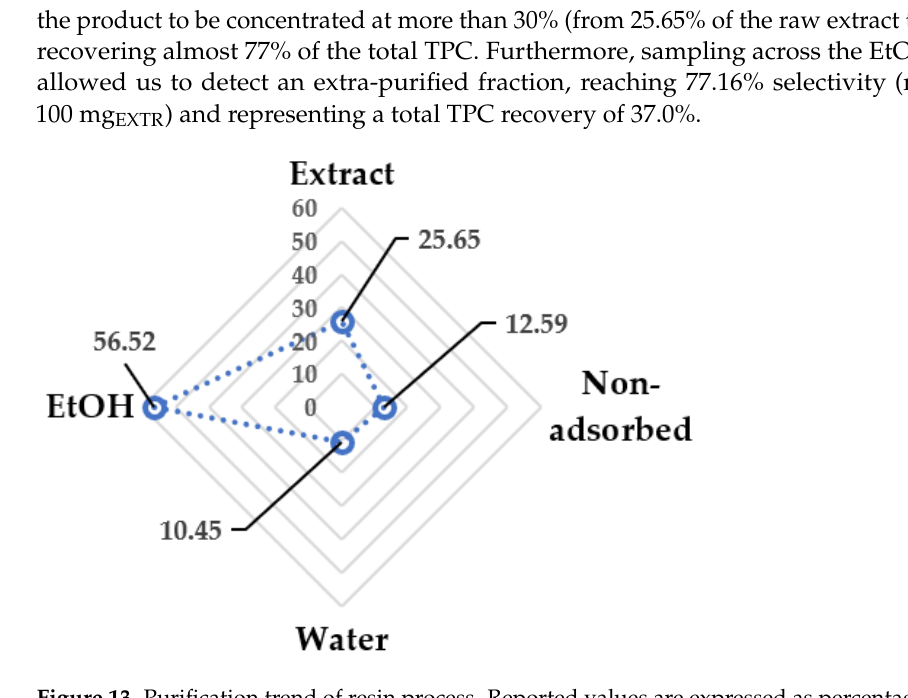
Figure 12. TPC recovery trend, depending on the different elution fractions.